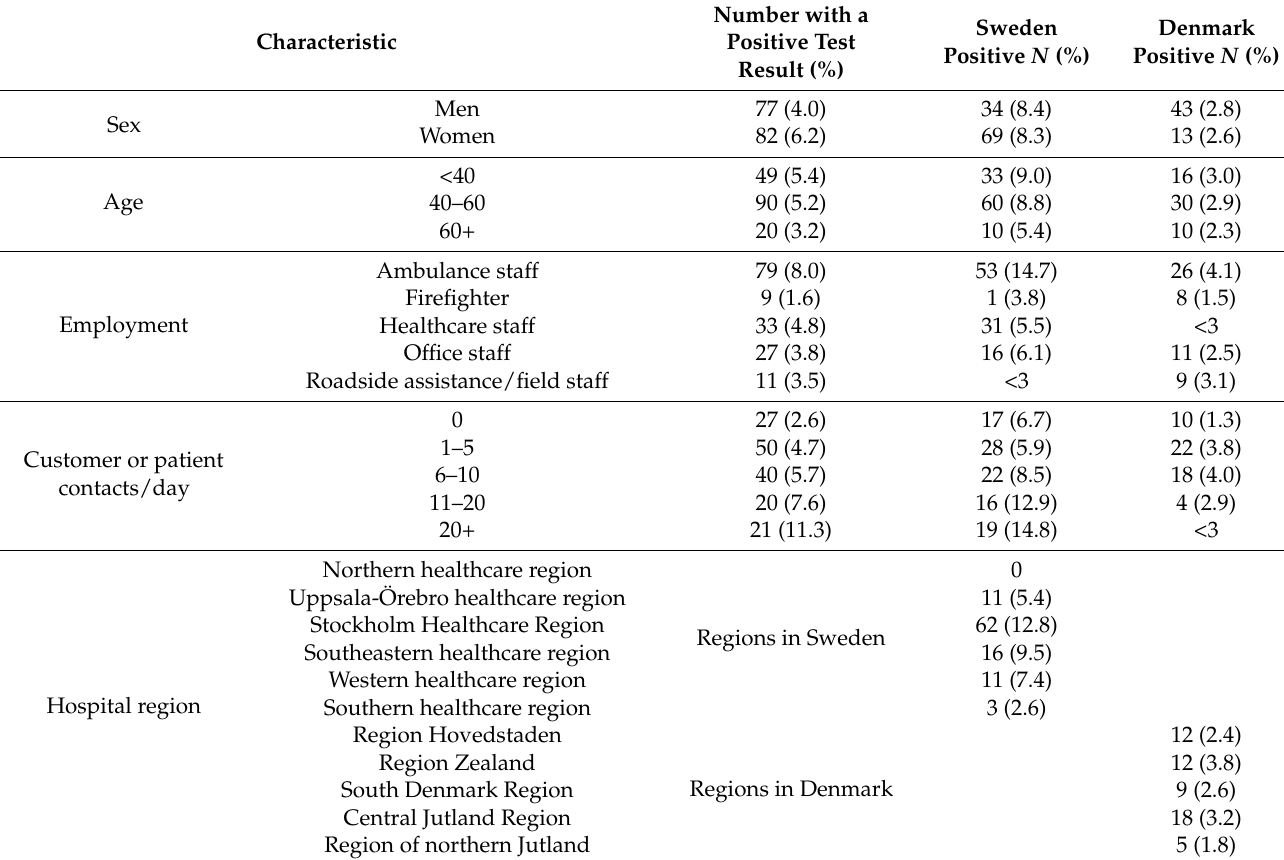
Table 2. Number and proportion of employees with at least one positive test and its dependence on employee